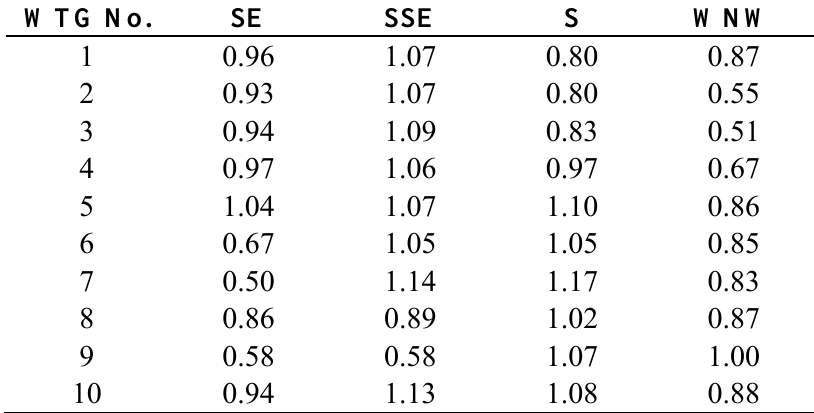
Table 1. Values of the fractional increase of the mean hub-height wind speed, EtCAL, calculated from the simulation results of the RIAM-COMPACT ® model (EtCAL: the ratio of the mean hub-height wind speed to the upper-air wind speed at the inflow boundary). WTG